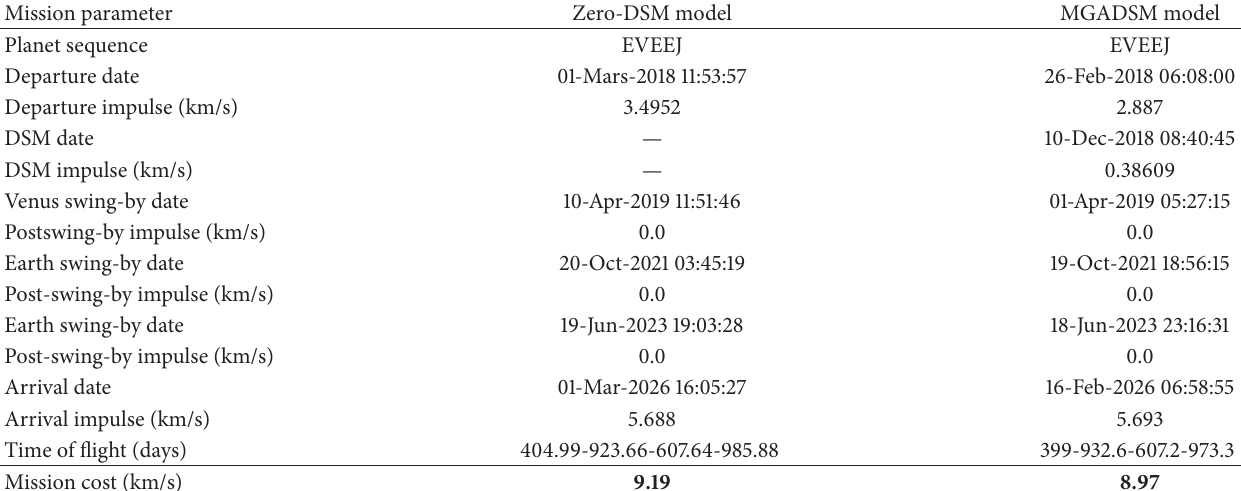
Table 8: Optimal trajectory of Earth-Jupiter mission (EVEEJ) using HGDE.